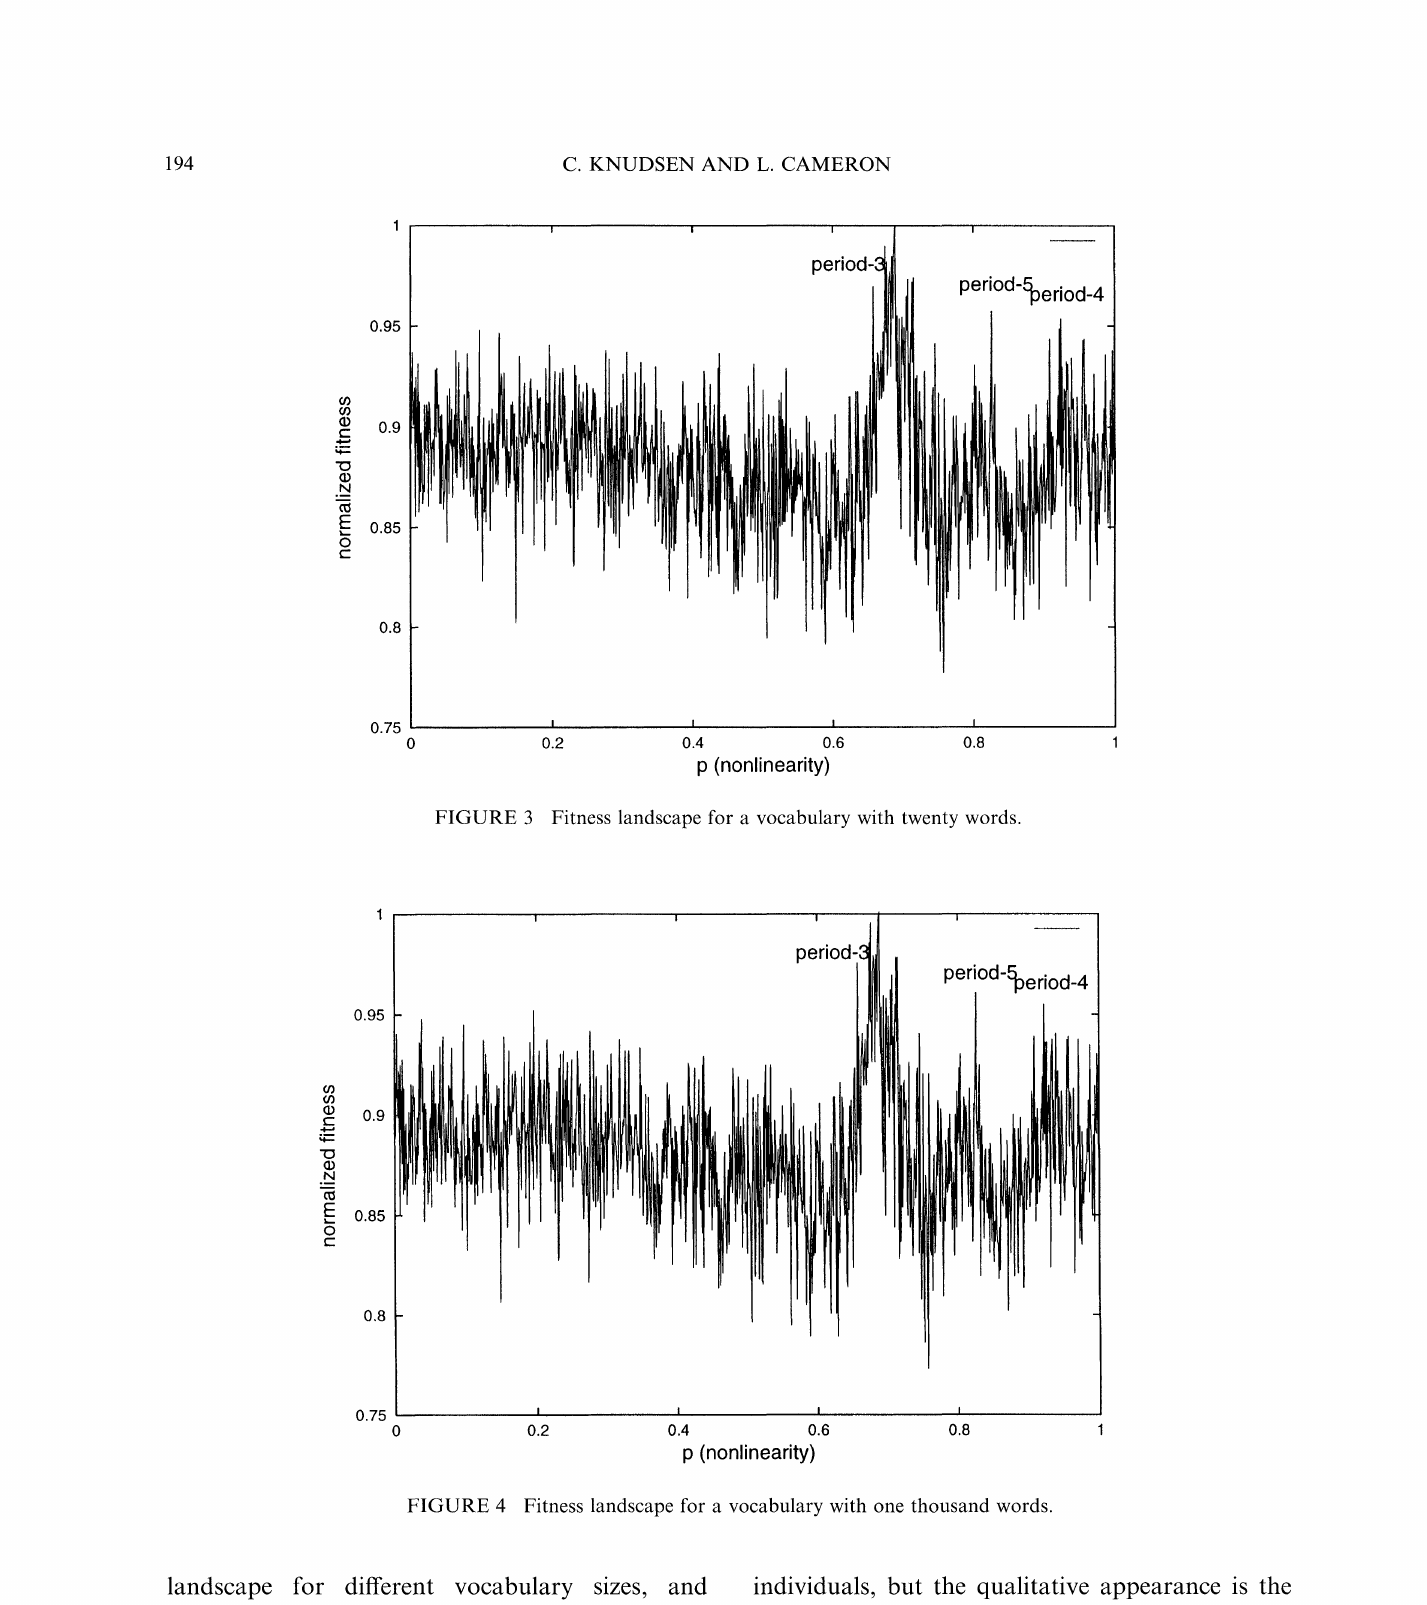
FIGURE 3 Fitness landscape for a vocabulary with twenty words.